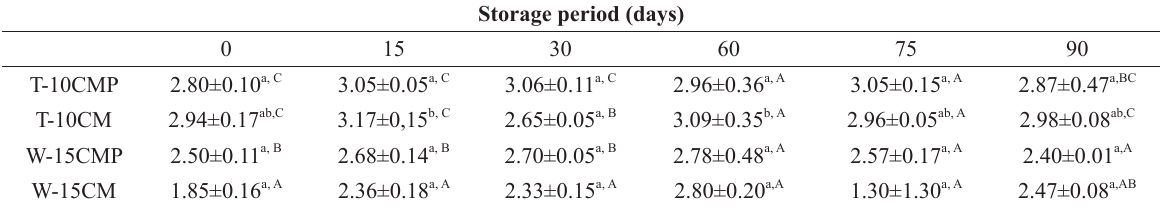
Changes in YMCs 1 (log cfu/g) of snacks during storage period.